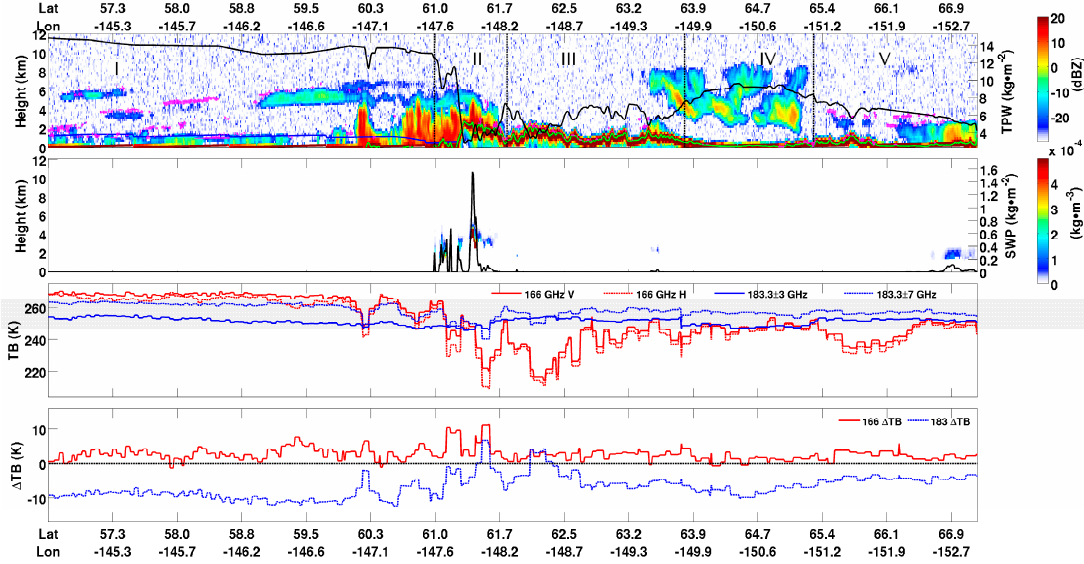
Figure 3. Same as in Figure 2a but for orographic event on 14 December 2014.